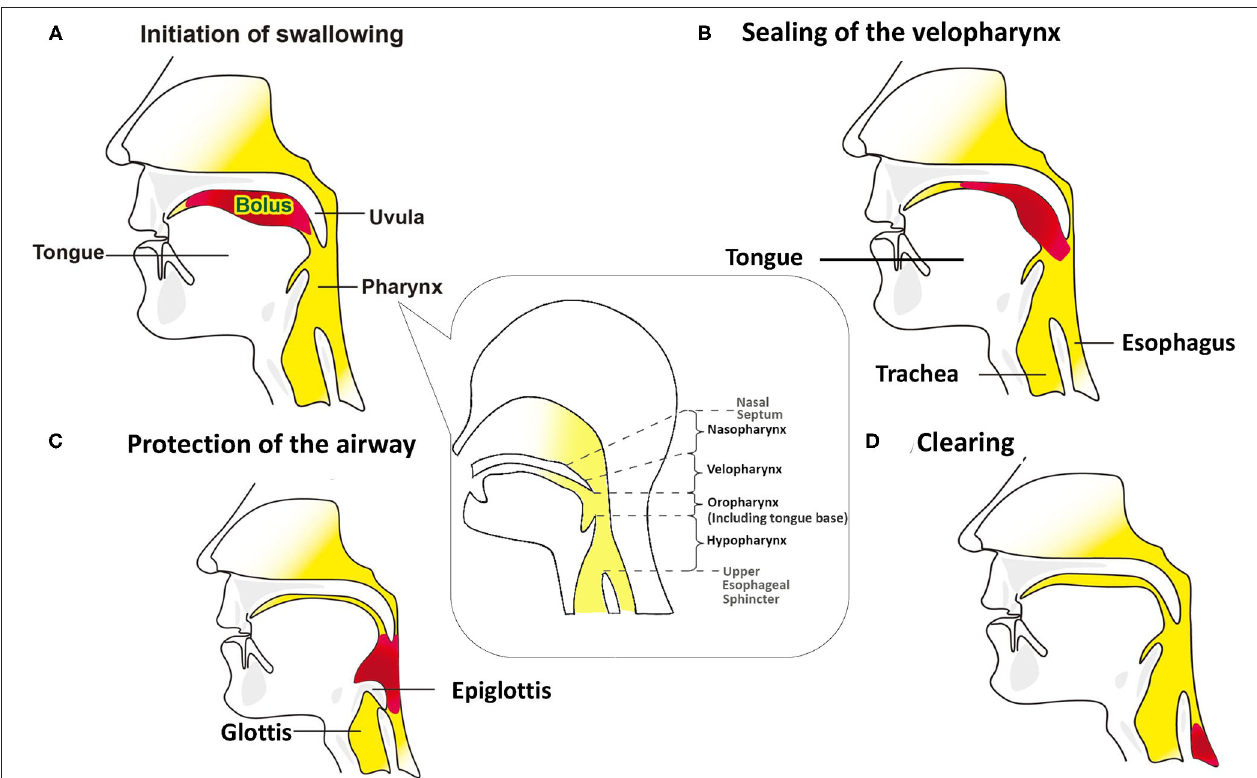
FIGURE 1 | Swallowing mechanisms of bolus through the oral cavity into the esophagus. The red pattern in (B–D) depicts the bolus in the same way that does in the (A) . (A) The bolus is kept in the oral cavity, initiating the swallowing process. The figure in the dialog box below the pharynx illustrates that the pharynx includes the velopharynx, oropharynx and hypopharynx. The base of tongue is part of the oropharynx, and usually not visible when the mouth is open. (B) During the pharyngeal phase, the velopharynx, oral cavity, and larynx are sealing, and the bolus is transmitted through the pharynx and into the esophagus by pharyngeal peristalsis. (C) Airway protection is essential during the swallowing process, which includes tilting back of epiglottis, closing the laryngeal vestibule, trucking of the sealed airway under the tongue base from the bolus path, and the neuronal suppression of respiration while the bolus passes through the pharynx. (D) As the bolus passing into the esophagus, the airway